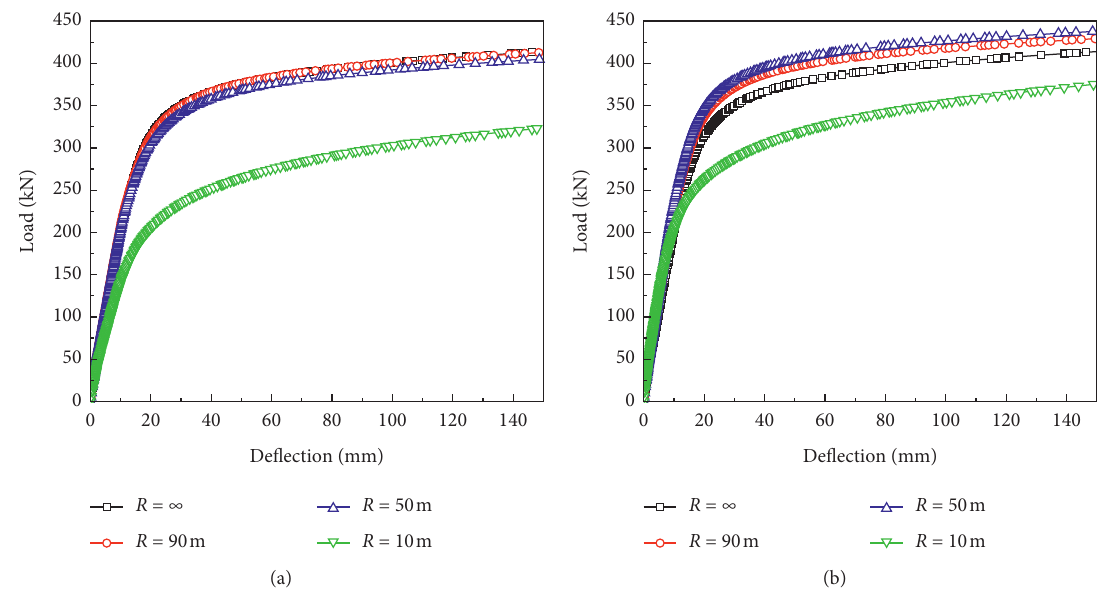
Figure 14: Load-deflection curves of curved TGCB models with different radius of curvature: (a) outer girder; (b) inner